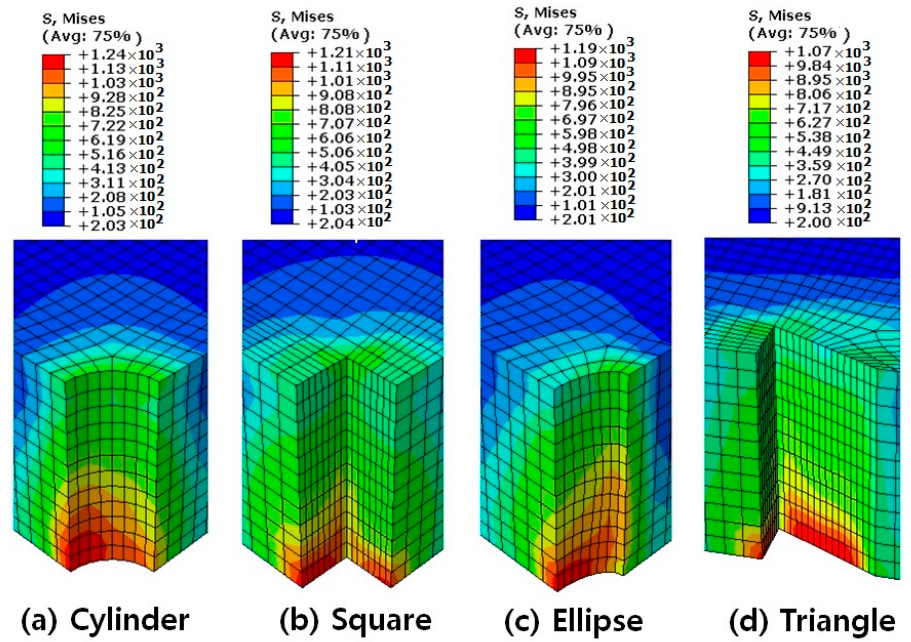
Figure 10. Von ‐ Mises stress distribution in different TSV shapes at 450 °C.